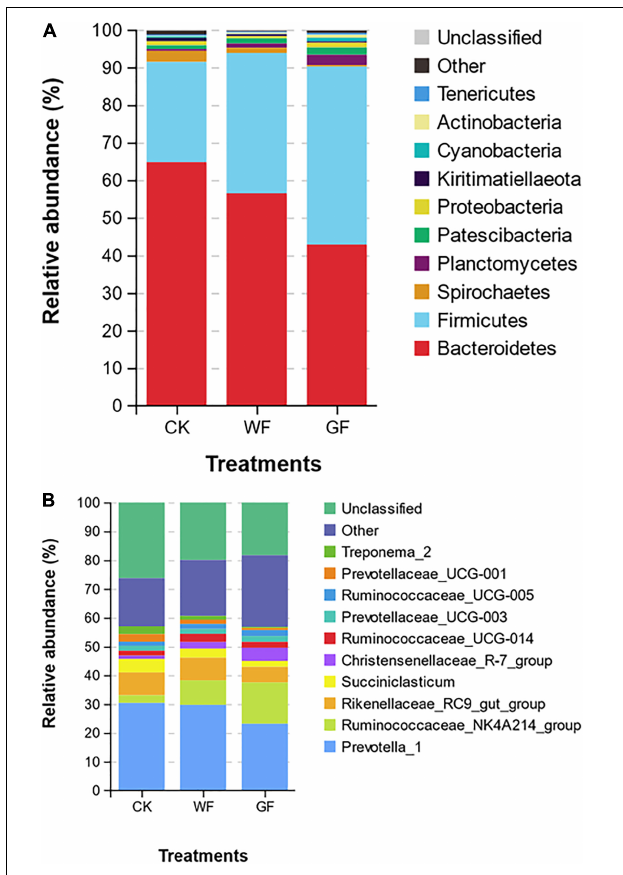
FIGURE 1 | (A) Relative abundance of the bacterial community on the phylum level (only the top 10 abundant phyla are presented). (B) Relative abundance of bacterial communities on the genus level (only the top 10 abundant genera are presented). CK, dairy cows fed with control check diet (without